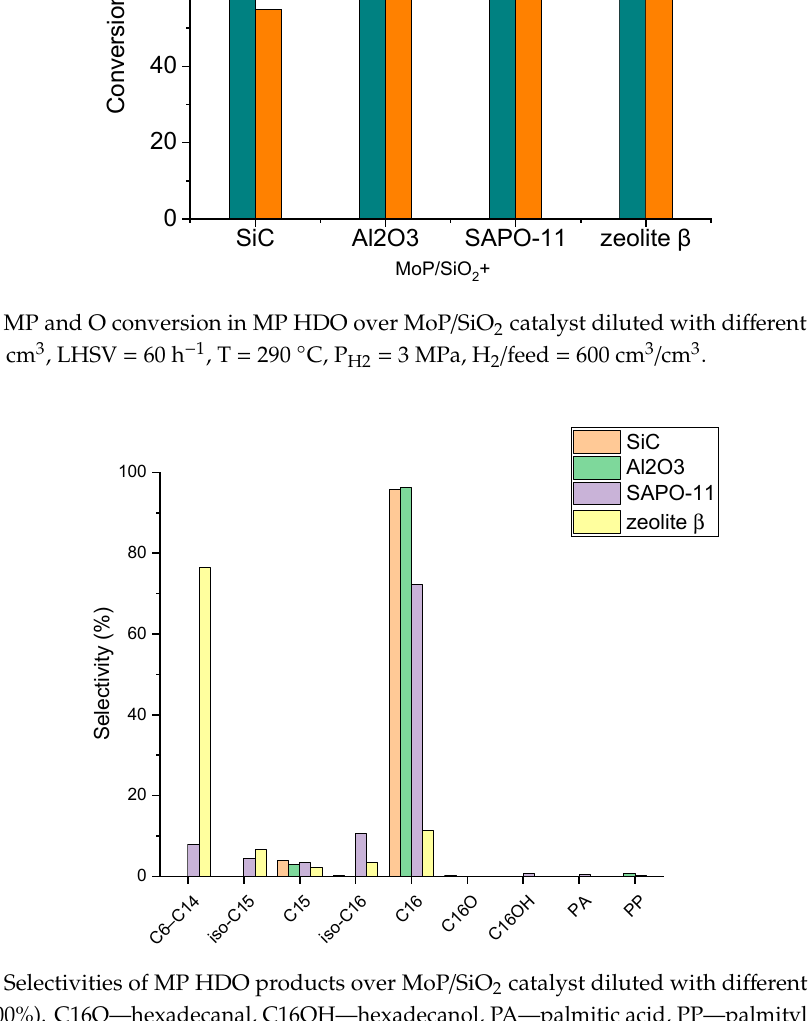
Figure 5. Selectivities of MP HDO products over MoP/SiO 2 catalyst diluted with different materials (X MP = 100%). C16O—hexadecanal, C16OH—hexadecanol, PA—palmitic acid, PP—palmityl palmitate. V cat = 1.8 cm 3 , LHSV = 10 h –1 , T = 290 °C, P H2 = 3 MPa, H 2 /feed = 600 cm 3 /cm 3 .